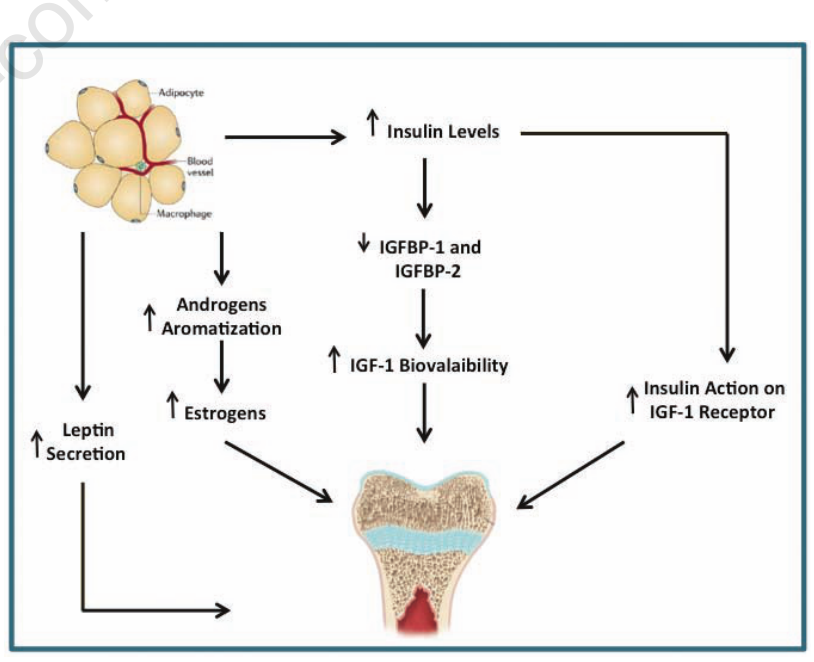
Figure 1. Mechanisms explaining growth hormone-independent growth in obese